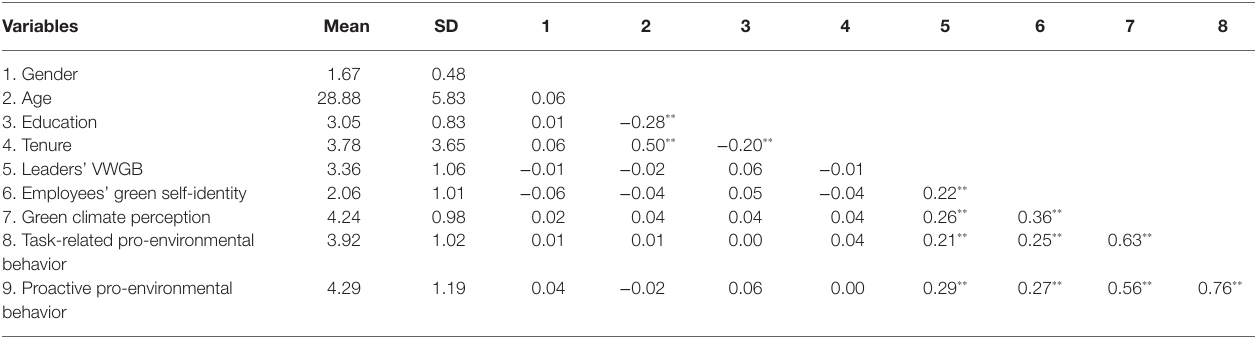
TABLE 2 | Means, standard deviations, and correlations.